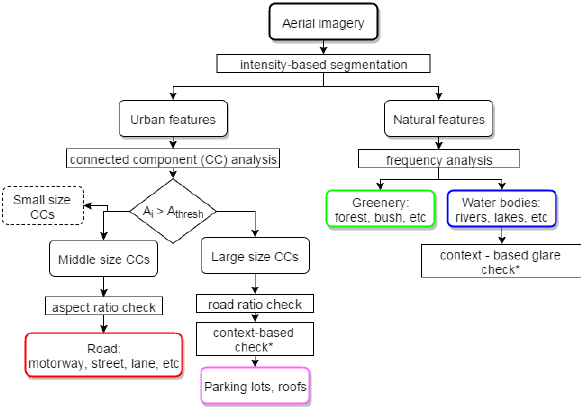
Figure 1: Image classification for visual feature